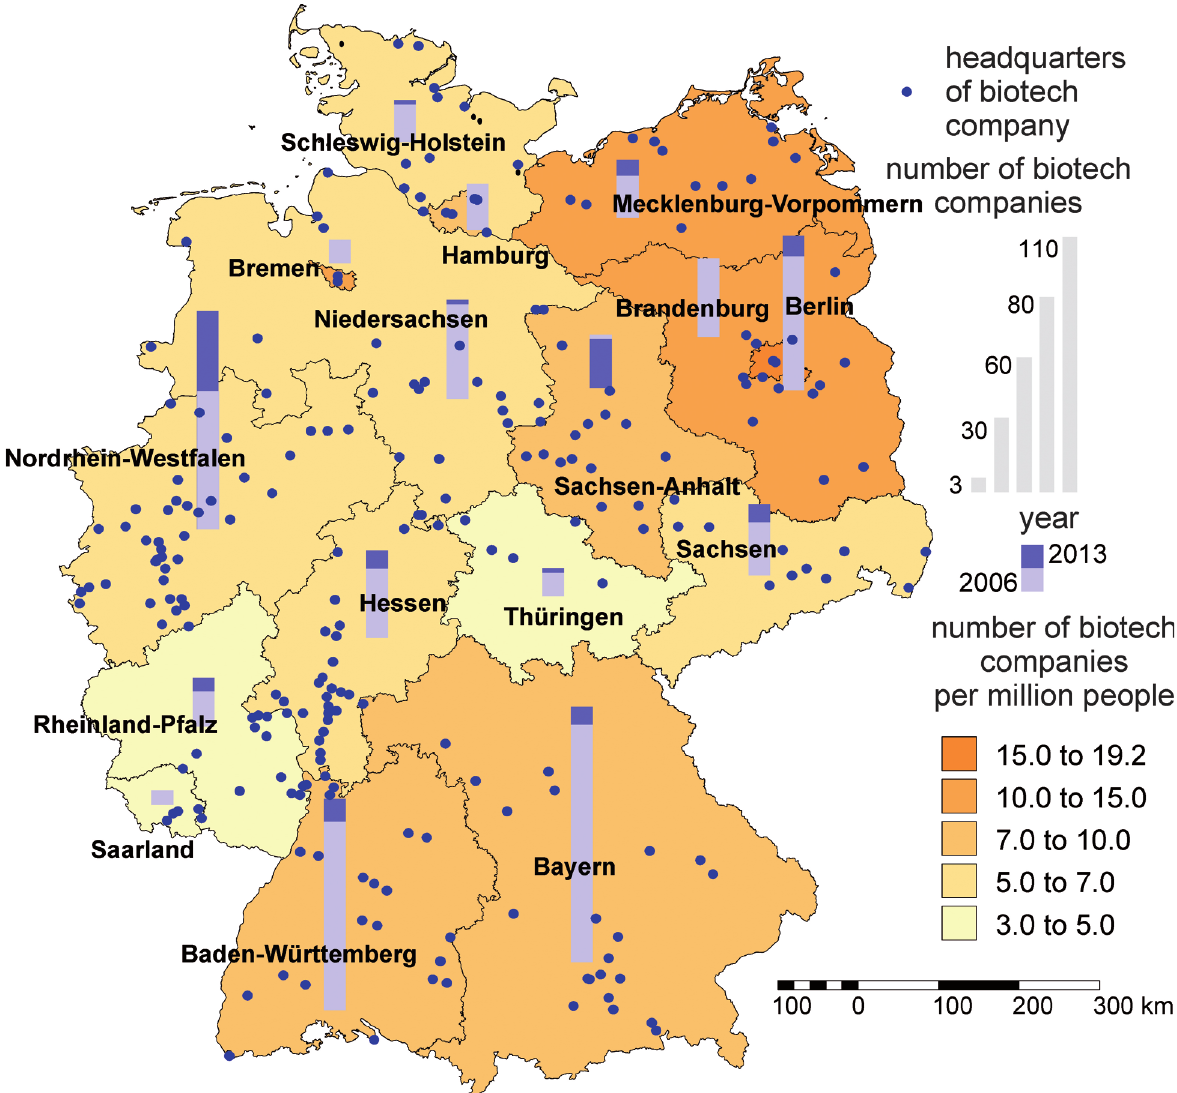
Fig. 6. Regional distribution of biotech companies in 2005 and 2013, and per million people Source: own calculations based on the Internet portal